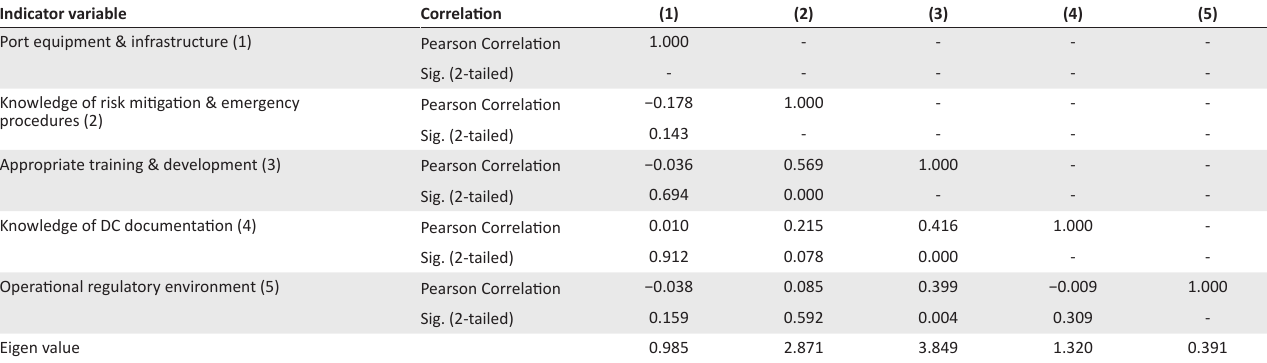
TABLE 4: Correlation matrix. † Indicator variable